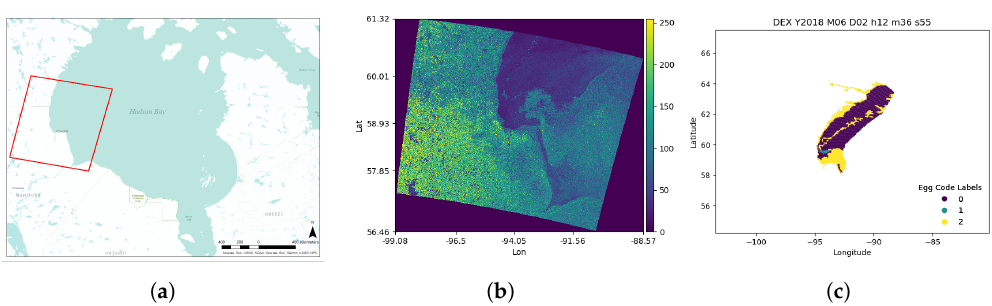
Figure 1. ( a ) Hudson Bay region. Input-output data sources: ( b ) Single raw SCW image. Input data consist of 350 RADARSAT-2 ScanSAR Wide images. ( c ) Labelled image analysis ice chart according to the scheme in Table 1. Output data consist of 172 image analysis